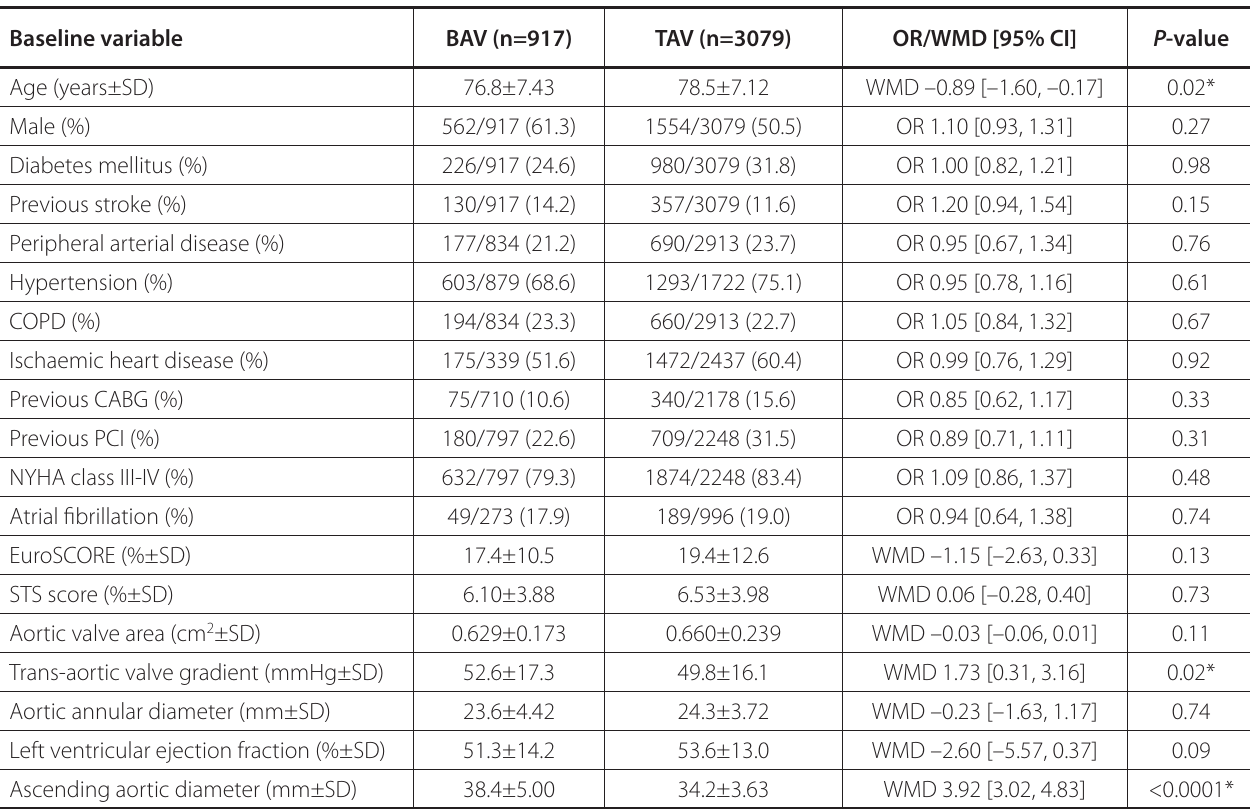
Table 2 . Newcastle-Ottawa Scale. Table 3 . Baseline characteristics of the included patients. The first number is the number of patients with the event or the sample mean value ± standard deviation of the variable, and the second is the number of patients for whom the event was described. Statistically significant differences were marked with an asterisk